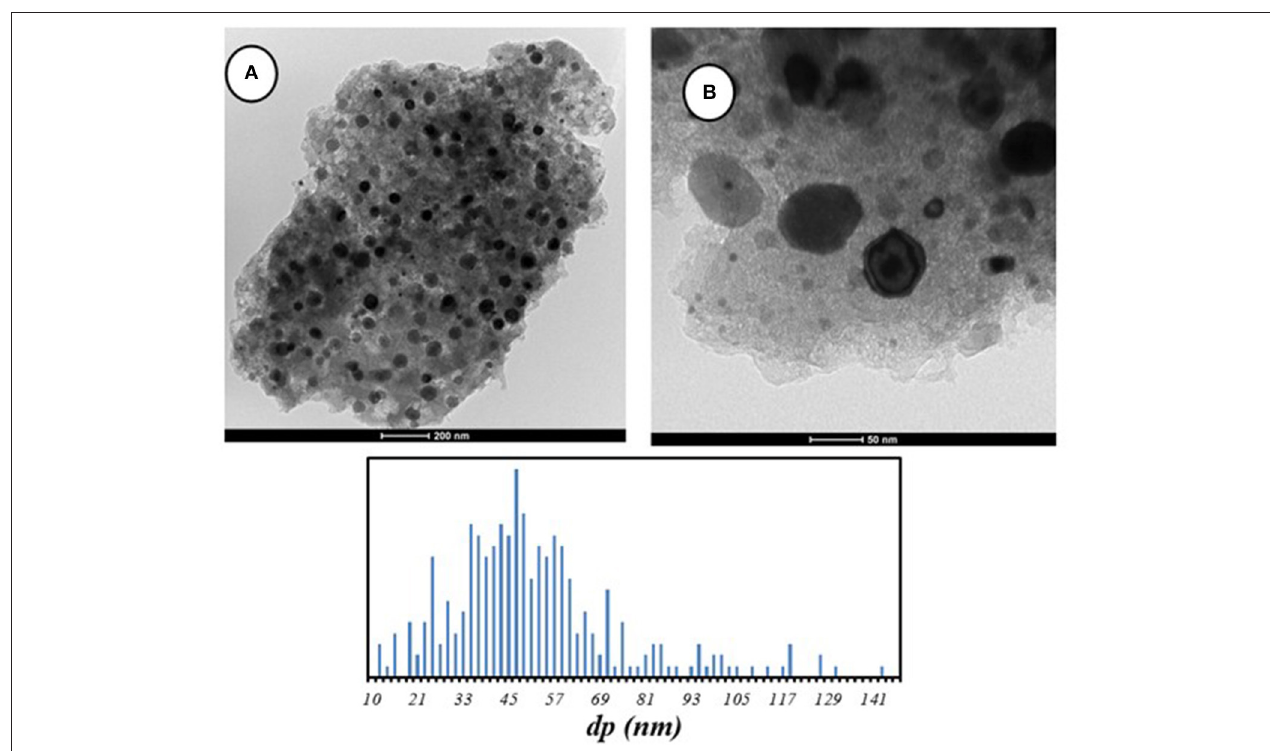
FIGURE 4 | TEM images and Ni particle size distribution of fresh catalyst. (A) and (B) corresponds to different magnifications of the TEM